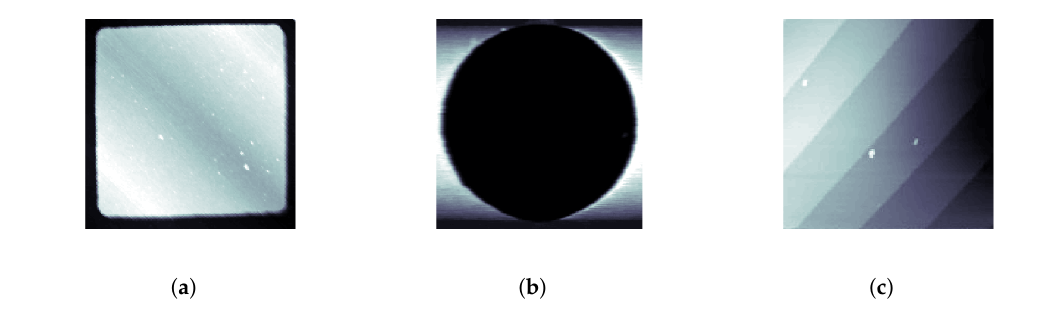
Figure 3. Raster scans showing the typical topology of square, circular and Si steps’ grating features. ( a ) Square grating; ( b ) Circular grating; ( c ) Si steps. (All images have been cropped from larger raster